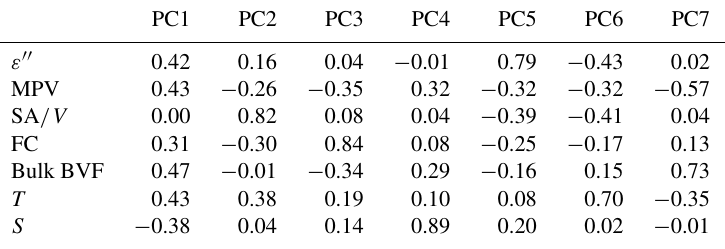
Table 4. Results from principal component analysis for ε (cid:48)(cid:48) at 10Hz and loadings associated with each variable. Mean pore volume (MPV), surface area to volume ratio (SA /V ), depth of 25% fractional connectivity (FC), bulk brine volume fraction (bulk BVF), sample brine volume fraction (sample BVF), ice temperature ( T ), and bulk ice salinity ( S ).